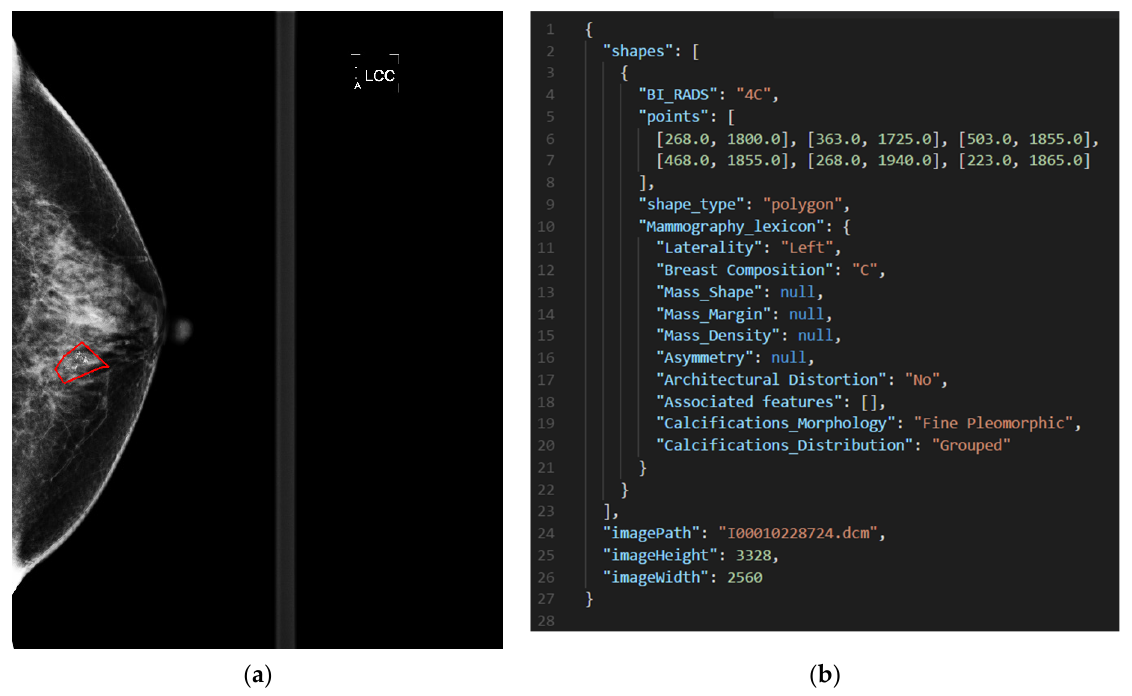
Figure 2. ( a ) A BI-RADS category 4C mammogram with a labeled lesion and ( b ) a JSON file that saved the annotation in ( a ).